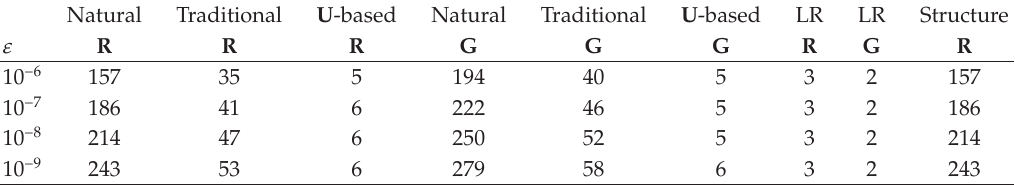
Table 1: Number of iterations required for di ff erent methods for interarrival times having probability vector a (cid:7) (cid:5) 0 . 1 0 . 2 0 . 2 0 . 5 (cid:6)